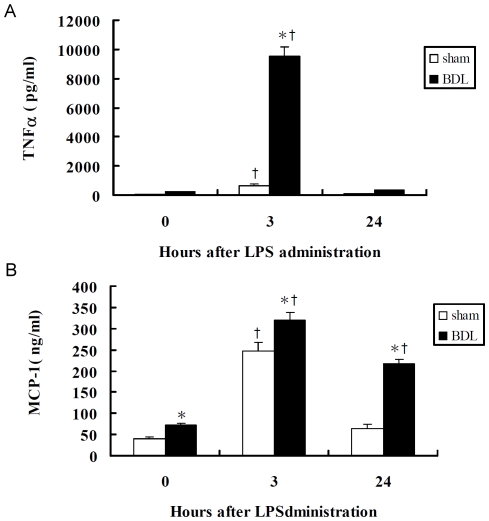
Effects of LPS treatment on BDL and sham-operated rats induced cytokine production.Plasma (A) TNFα and (B) MCP-1 were measured after 0.5 mg/kg LPS administration. All values are averages of 5–10 rates. Data represent mean±SE. * indicated P<0.05 versus time-matched values for the Sham-operated group; † indicates P<0.05 versus values for levels in untreated groups (0 h) of BDL or Sham-operated rats (as determined by two-way ANOVA using Bonferroni's post hoc test).